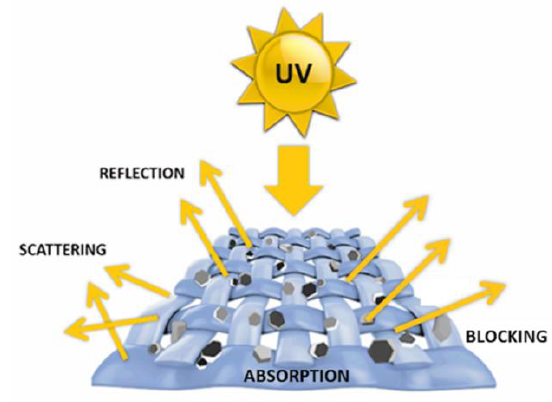
Figure 7. Schematic presentation of the UV protection mechanism of ZnO particles on textile fibers.